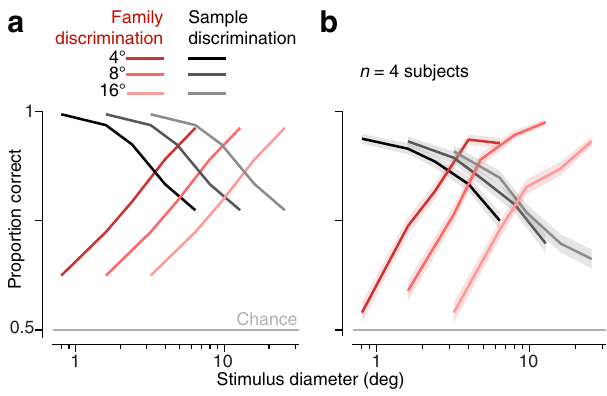
Fig. 4 Opposing effects scale with eccentricity. a Observer model performance ( s = 0.84, SNR = 0.5) in family and sample discrimination for different stimulus diameters and eccentricities (note: plotted against log diameter, to facilitate comparisons). b Average performance of four subjects performing family and sample discrimination under the same stimulus conditions. Red lines indicate family and black lines indicate sample discrimination. Lighter colored lines indicate larger eccentricities. Shaded regions indicate mean ± SEM across all trials. Source data are provided as a Source Data fi increased by the same factor 44,45 . We veri fi ed this property by computing model performance at eccentricities two and four times those of our original simulations (Fig. 4a, lighter shaded lines). As expected, the curves representing family and sample discrimination performance maintain their shape and relation- ship to one another, but are shifted rigidly along a logarithmically scaled axis of stimulus diameter (Fig. 4a).